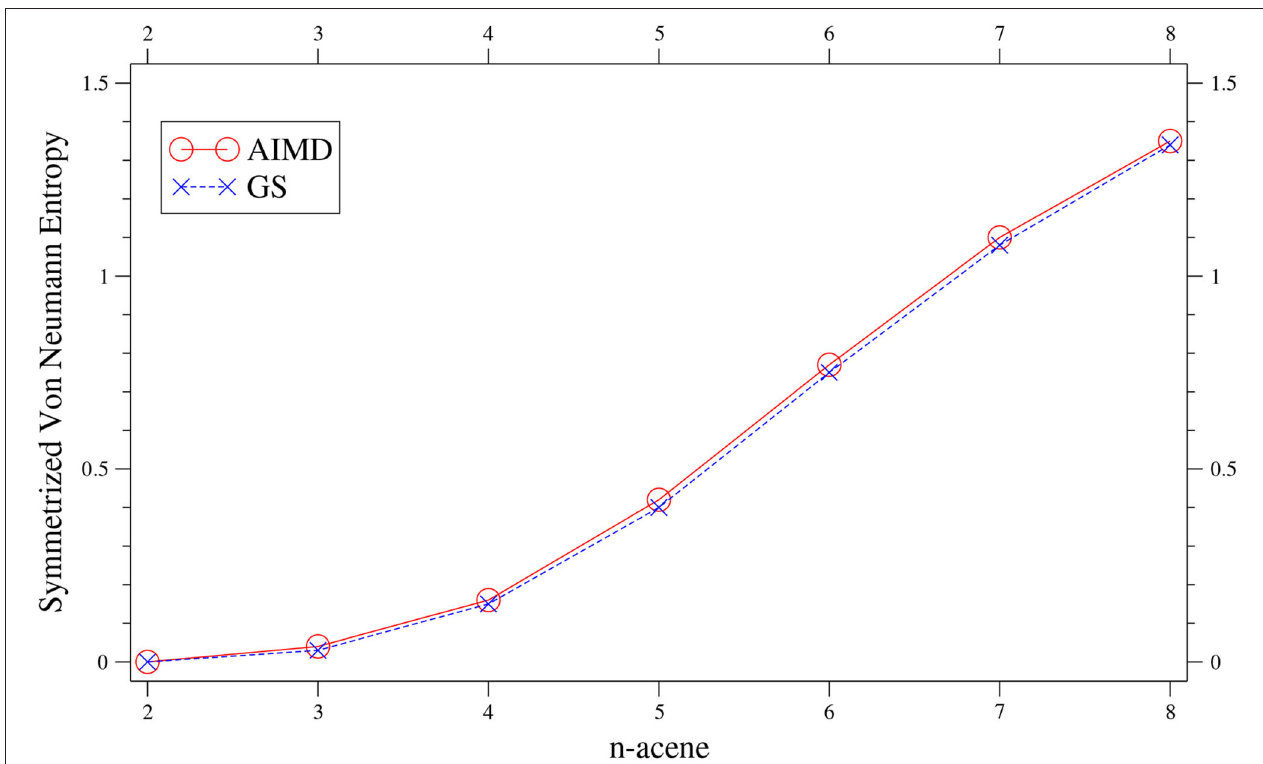
FIGURE 2 | Symmetrized von Neumann entropy of n -acene, obtained with the TAO-AIMD simulations at 300 K and GS calculation, calculated by TAO-LDA.